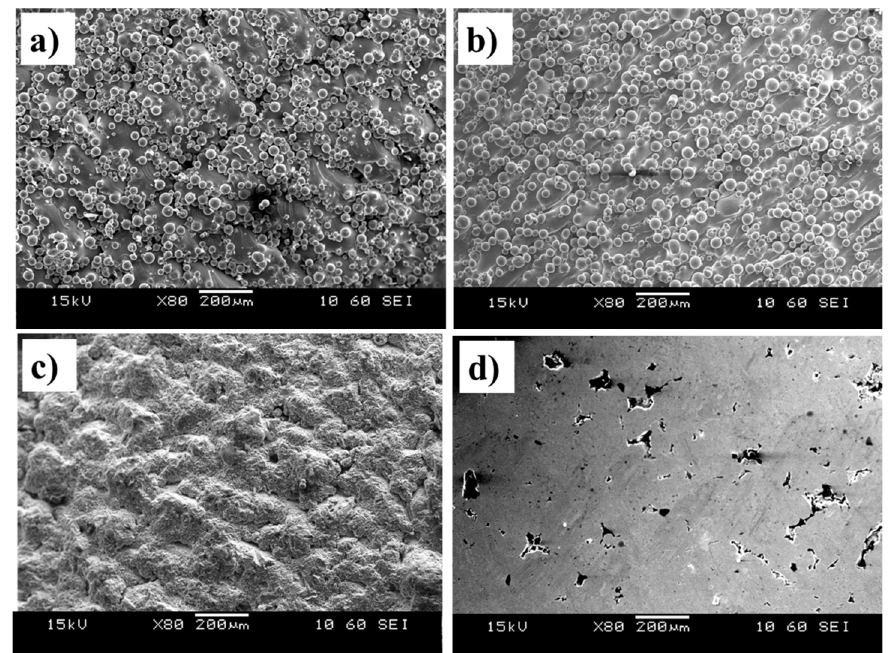
Figure 5. SEM images of top surfaces of ( a ) as‐fabricated and samples with post‐processing treatments; ( b ) HIP, ( c ) sandblasted and ( d ) polished SLMed Ti‐6Al‐4V parts. ( b ) HIP, ( c ) sandblasted and ( d ) polished SLMed Ti-6Al-4V